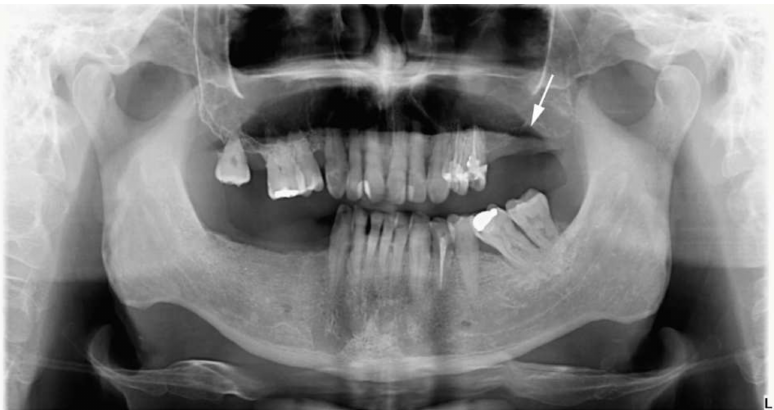
Figure 4. Orthopantomography with the maxillary lesion on the left molar region.